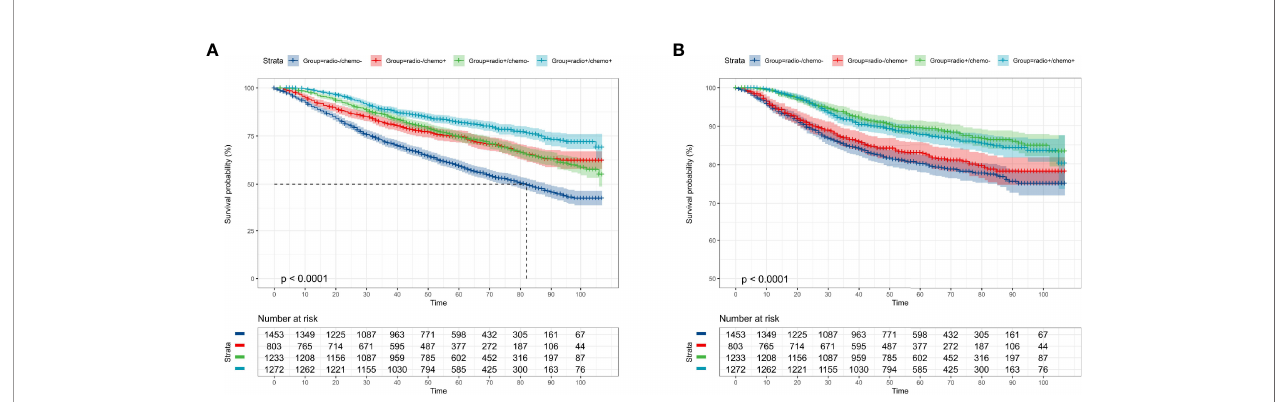
FIGURE 3 | Kaplan – Meier overall survival and cancer-speci fi c survival analyses of 4,761 women aged 70 years or older with primary operable, triple-negative breast cancer who received both chemotherapy and radiotherapy (radio+/chemo+), received only radiotherapy (radio+/chemo-), received only chemotherapy (radio-/chemo+), or did not receive radiotherapy and chemotherapy (radio-/chemo-). (A) adjuvant treatment for OS; (B) adjuvant treatment for CSS. OS, overall survival; CSS, cancer-speci fi c survival. Tick marks indicate censored